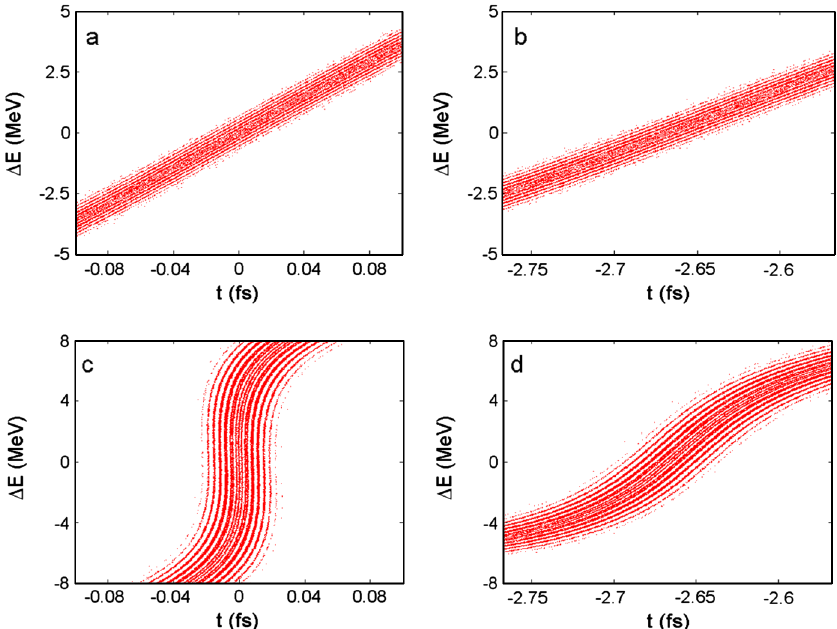
FIG. 6. (Color) Longitudinal phase space at the exit from M3 for the electrons in region 1—(a) and those in region 2—(b). Longitudinal phase space at the entrance to the radiator for the electrons in region 1—(c) and those in region 2—(d).